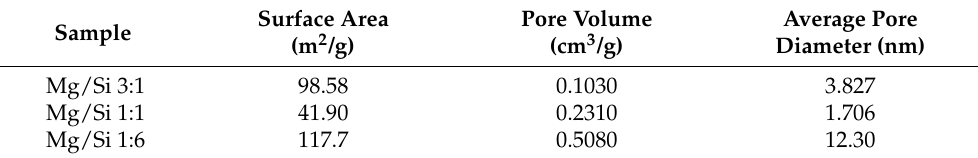
Table 1. BJH analysis of the magnesium silicate with different ratios of